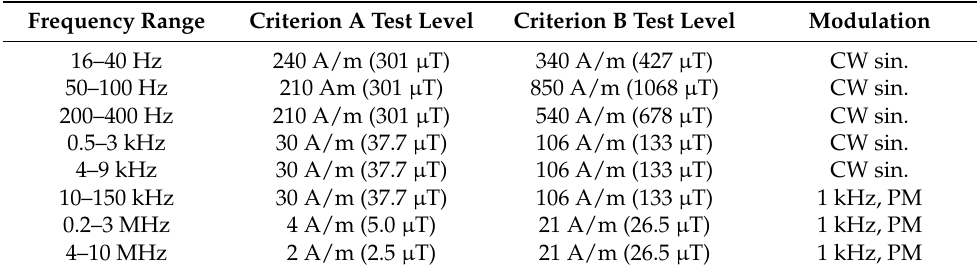
Table 4. Immunity to magnetic fields between 16.6 Hz and 10 MHz for cochlear and auditory brainstem implants.